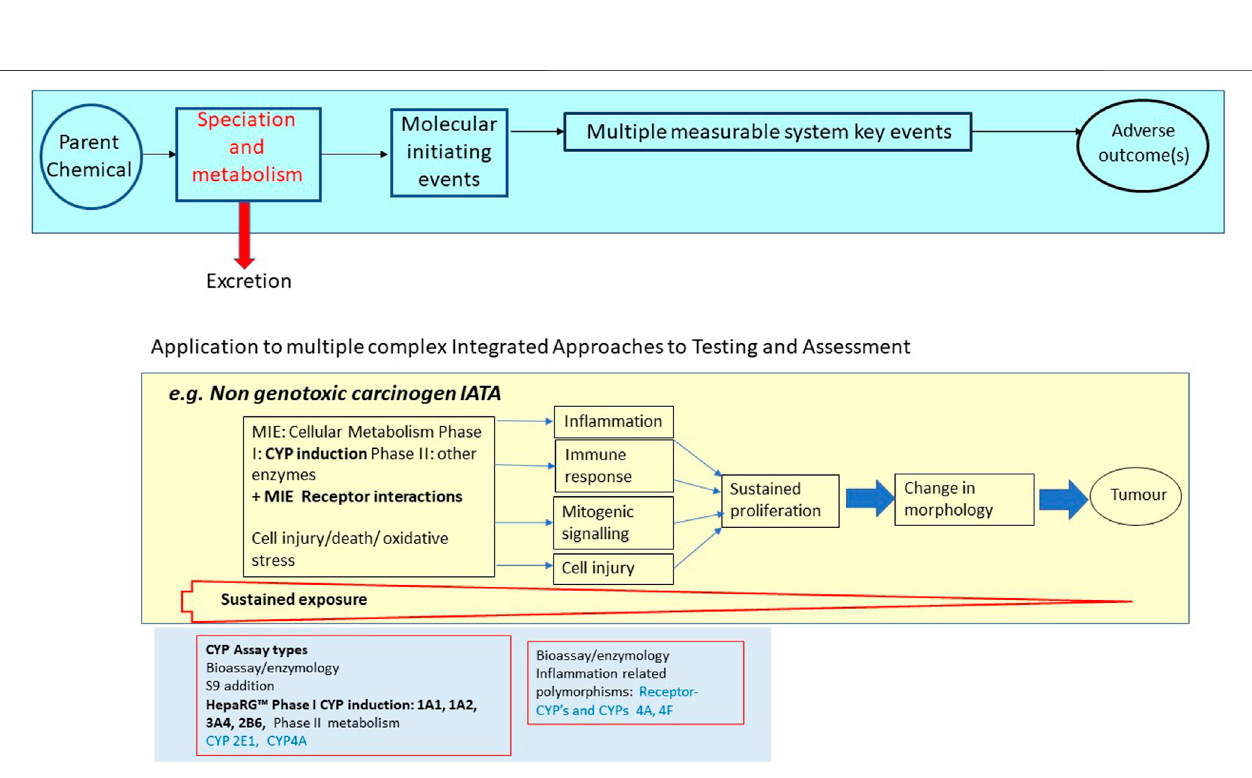
FIGURE 1 | panel (B) Metabolic activation or deactivation ofa chemical, generation of and positioning of CYP induction data in an Integrated Approach for Testing and Assessment of Non Genotoxic Carcinogens.